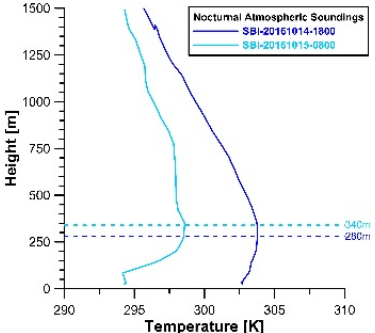
Figure 14. Breaking-off of the surface-based inversion developed from the sunset of 14 October to the early morning of 15 October, during the summer 2010 campaign in the Mexicali Valley. As we observed in Table 6, the radiosonde (RS) profile 20161015-08:00 revealed a subadiabatic near-surface temperature lapse rate of Γ = − 0.0046 K / m.